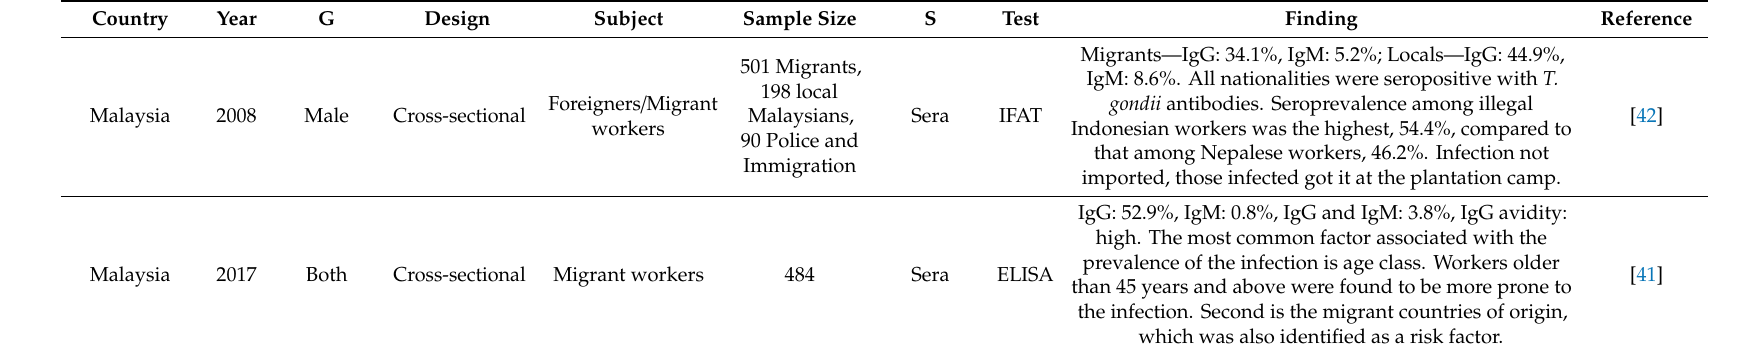
Table 4. Serological prevalence of toxoplasmosis among migrant workers in